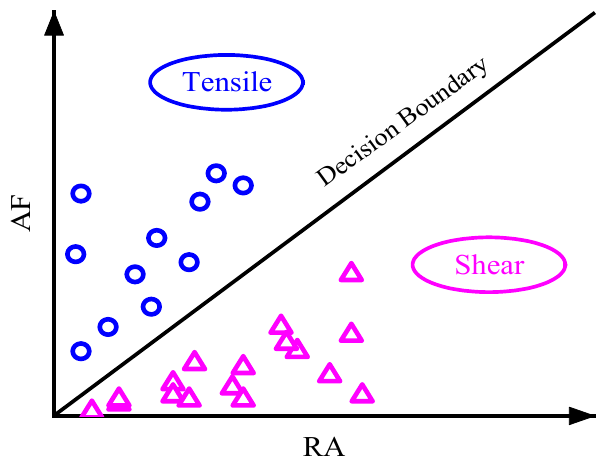
Figure 7. Typical fracture modes and corresponding AE waveforms.